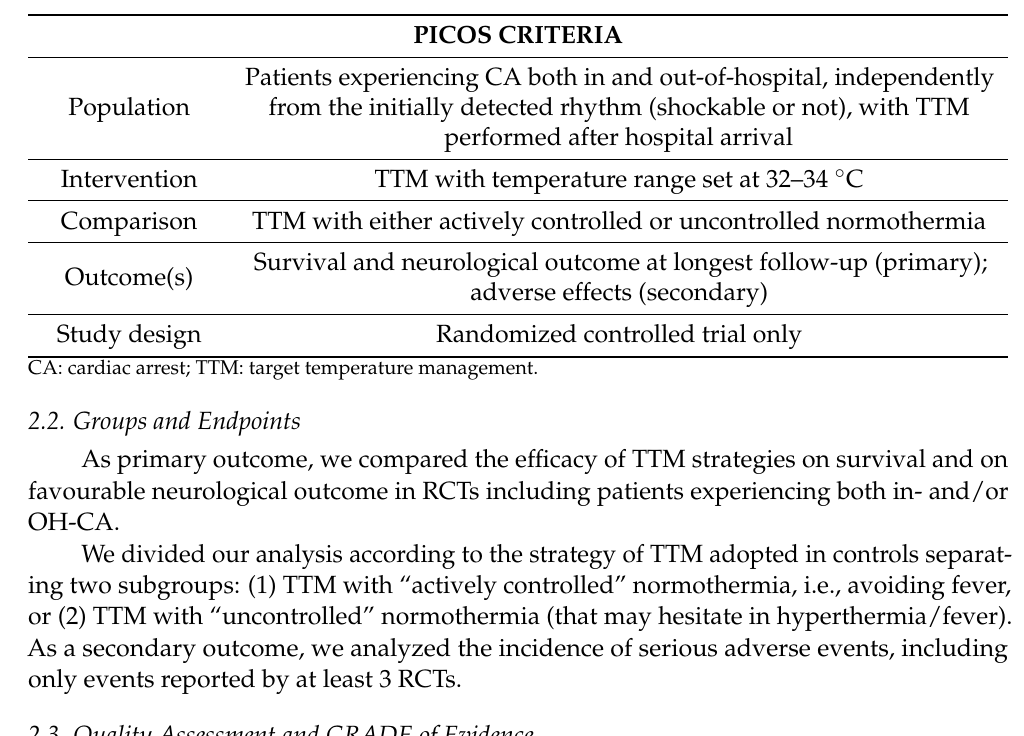
Table 1. “PICOS” approach for selecting clinical studies in the systematic search and